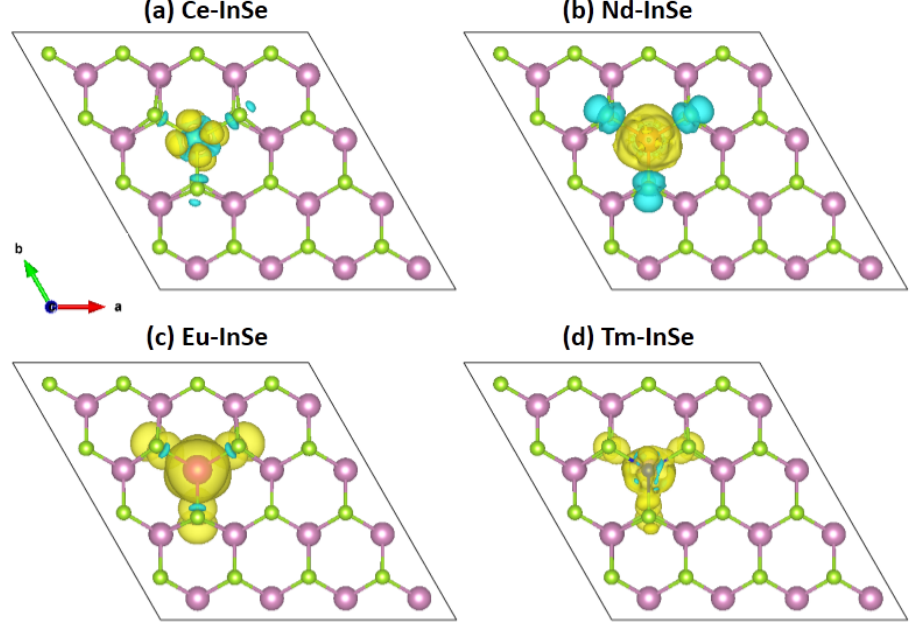
Figure 2. ( a – d ) Spin density of Ce-doped ( a ), Nd-doped ( b ), Eu-doped ( c ), and Tm-doped ( d ) InSe monolayer. The yellow and cyan isosurface represents the positive and negative spin density, respectively. The isosurface value is set to be 0.0003 e/Å 3 .